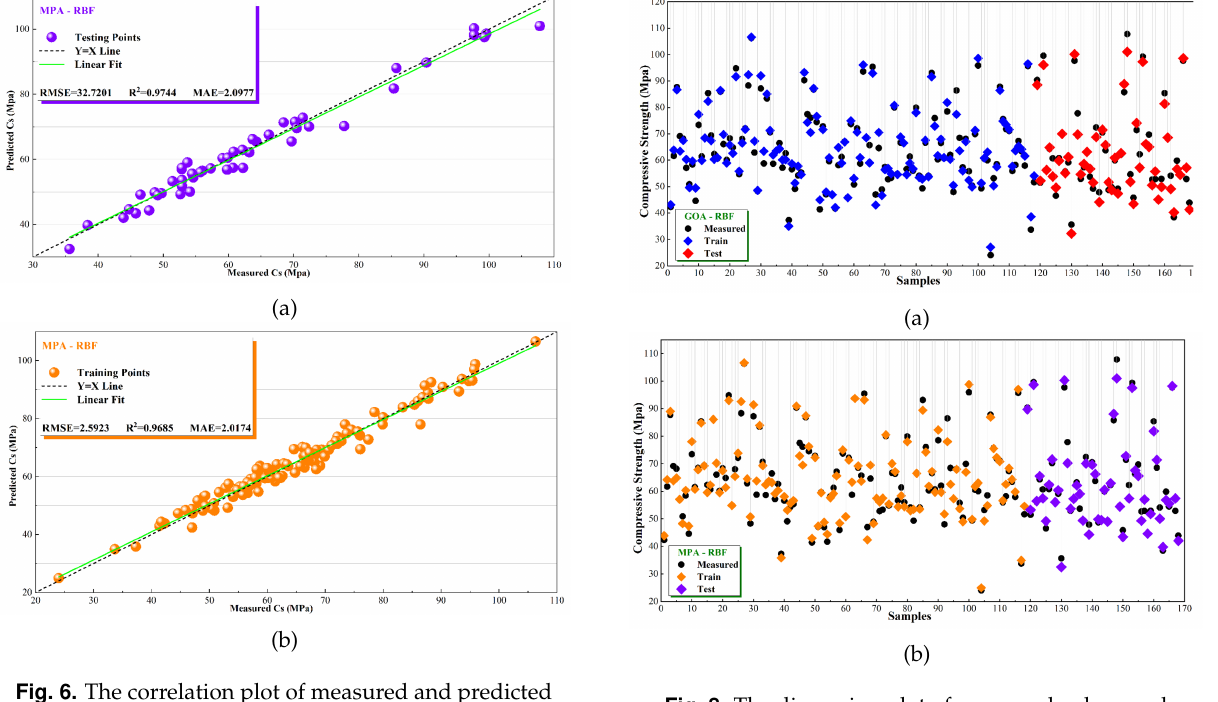
Fig. 8. The dispersion plot of measured values and predicted values of compressive strength